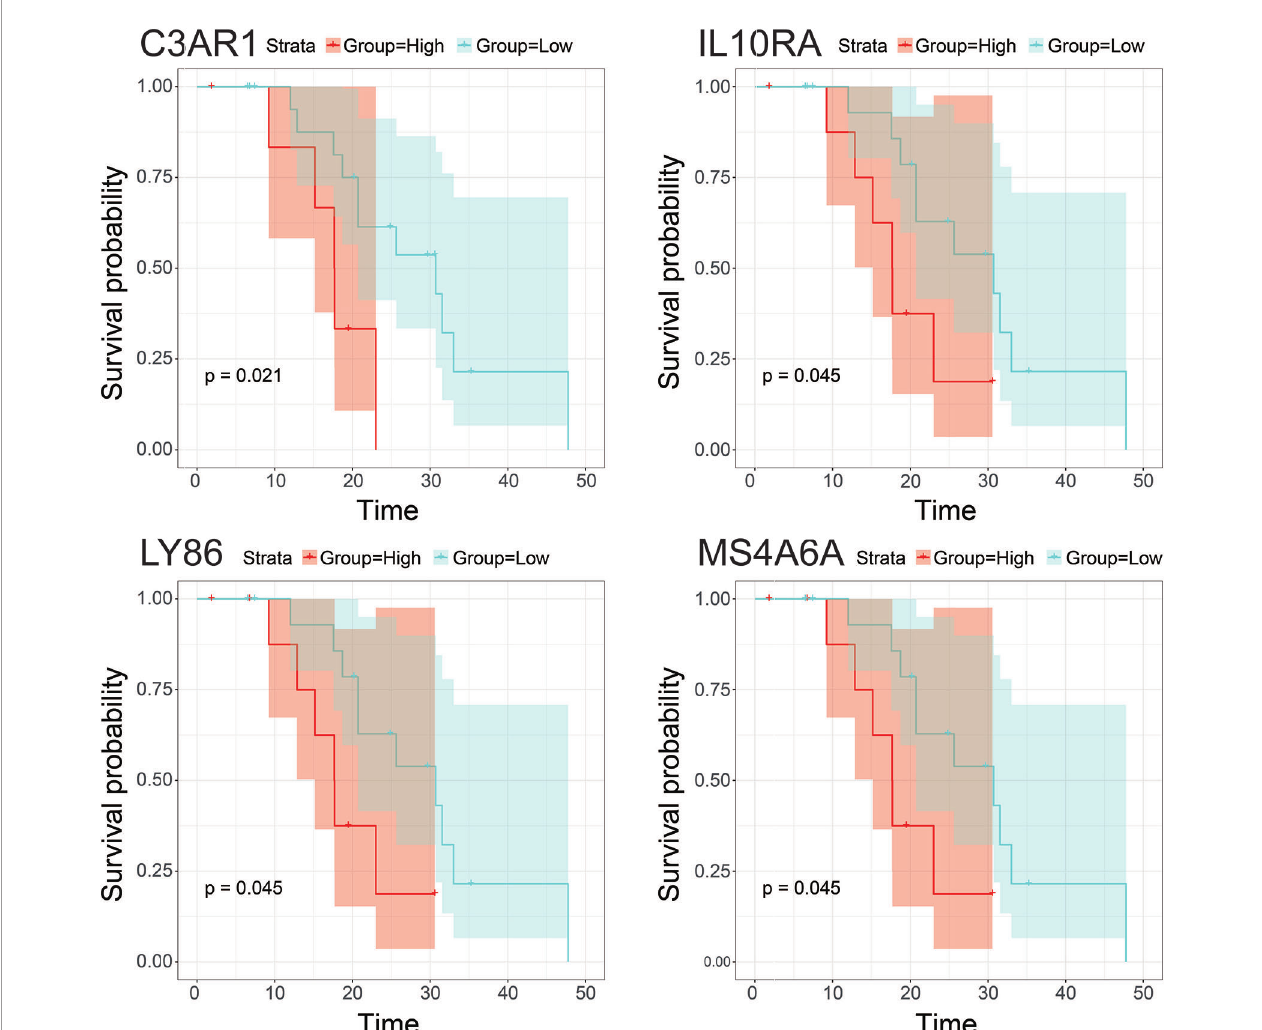
FIGURE 6 | Survival analysis of hub gens with statistical signi fi cance (pvalue<0.05) in the dataset derived from Abida W ’ s study. Orange lines represent high expression of the hub genes and blue lines represent low